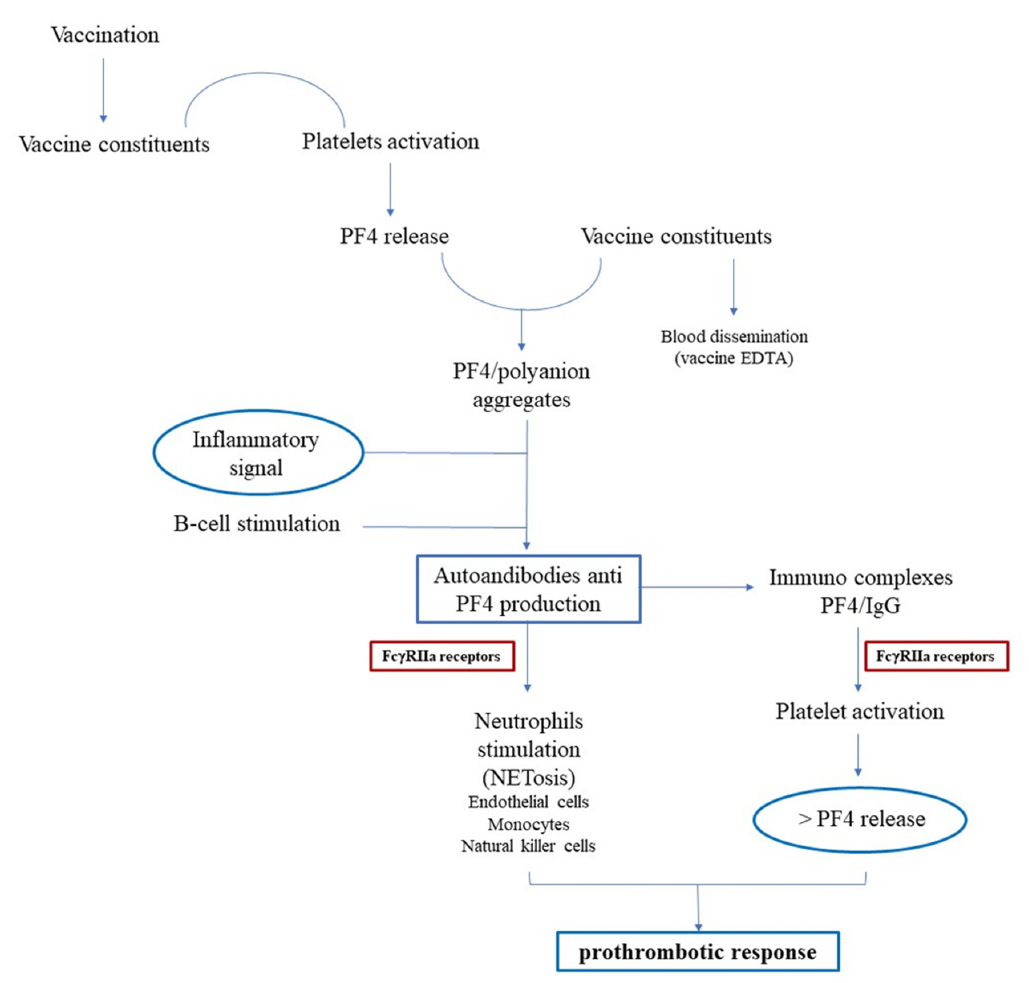
Figure 2. Schematic representation of suggested vaccine adverse vascular reaction. Vaccine constituents interact with platelets, determining platelet activation and PF4 release; PF4 binds vaccine constituents (possibly disseminated in blood for EDTA-related capillary leakage) forming aggregates; an inflammatory signal is generated with production of IgG anti-PF4-forming immuno-complexes PF4 (with vaccine constituents) and IgG; the immune complexes both stimulate neutrophils (and, possibly, endothelial cells, monocytes, and natural killer cells) and activate platelets releasing additional PF4, together determining a prothrombotic response.